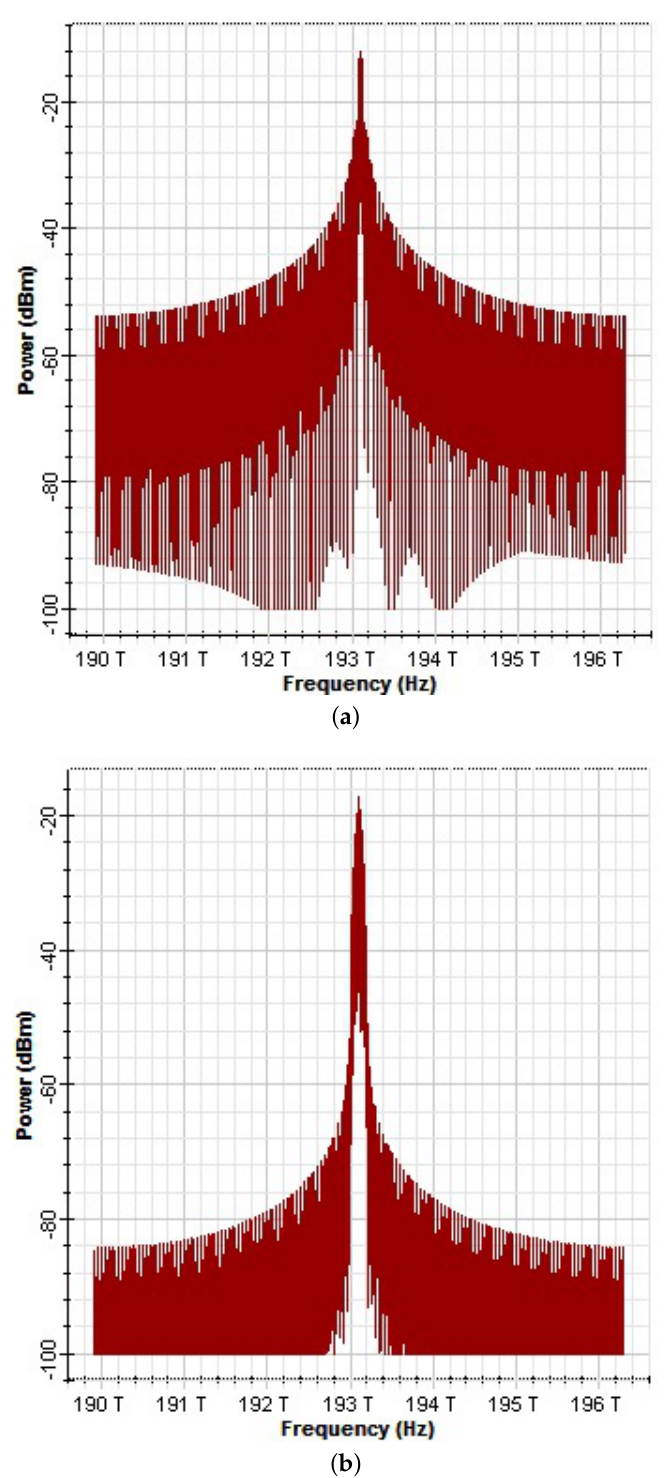
Figure 8. ( a ) Optical spectrum analyzer diagram for interrupted signals due to addition of unwanted data. ( b ) Secured optical spectrum analyzer